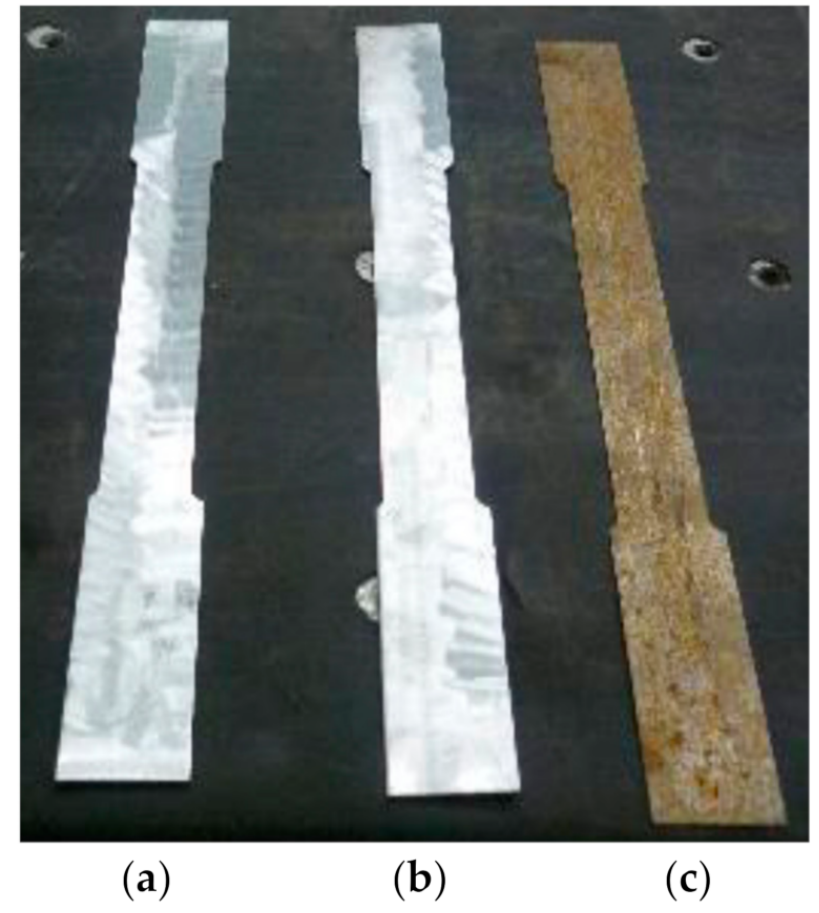
Figure 3. Prepared materials for tension test: ( a ) main plate; ( b ) cover plate; ( c ) cross_section plate.